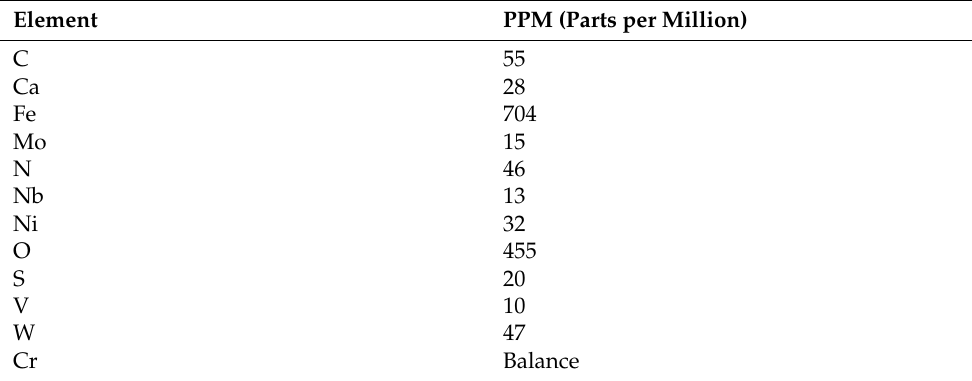
Table 1. Chemical composition of the chromium